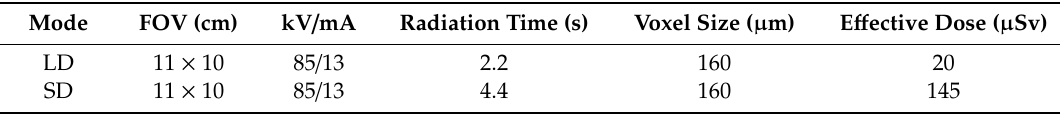
Figure 1. Screenshots of the four lesion types imaged with low-dose (upper row) and standard-dose mode (lower row) of cone-beam computed tomography (CBCT). Table 1. Low-dose and standard-dose mode settings of the Orthophos SL (Dentsply Sirona, York, PA, USA) [20].